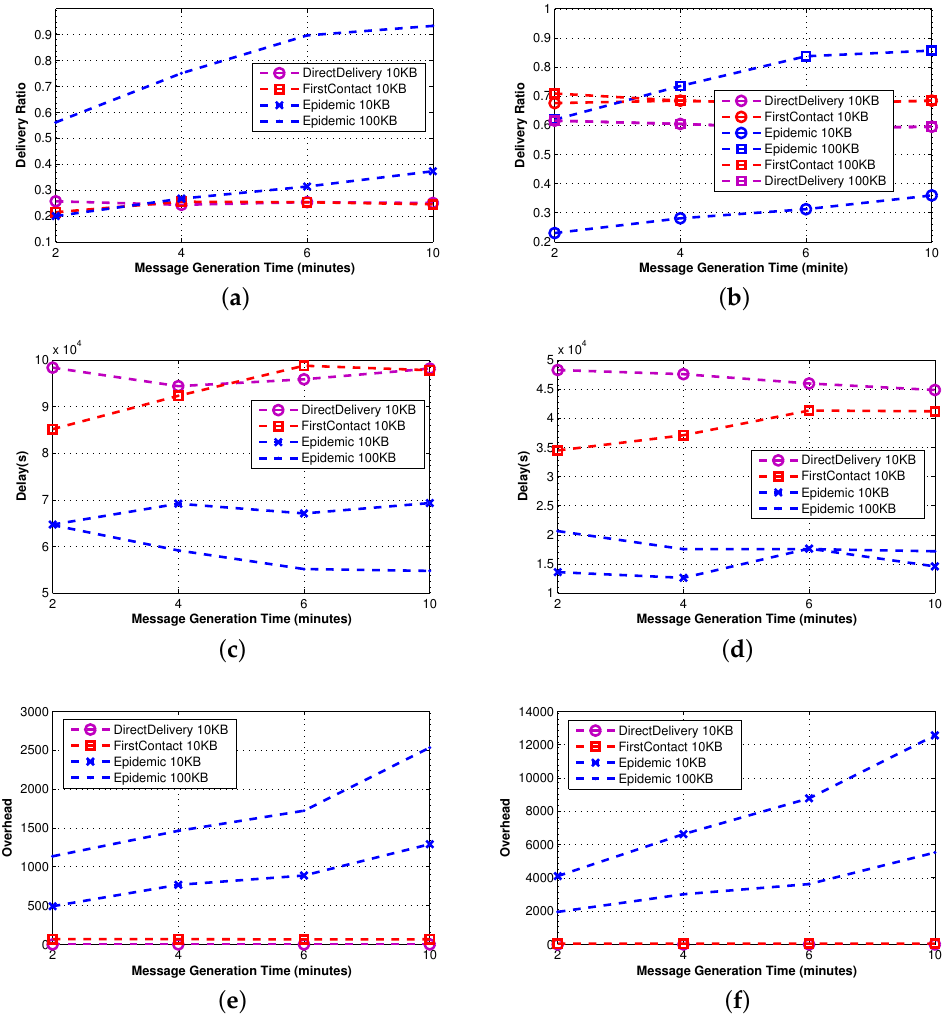
Figure 5. Simple protocols: Levy Walk (LW) ( a , c , e ) vs. Infocom ( b , d , f ). For the sake of readability: if the difference between the 100-KB and 10-KB plots for a protocol is within 5%, we do not show the 100-KB plot.